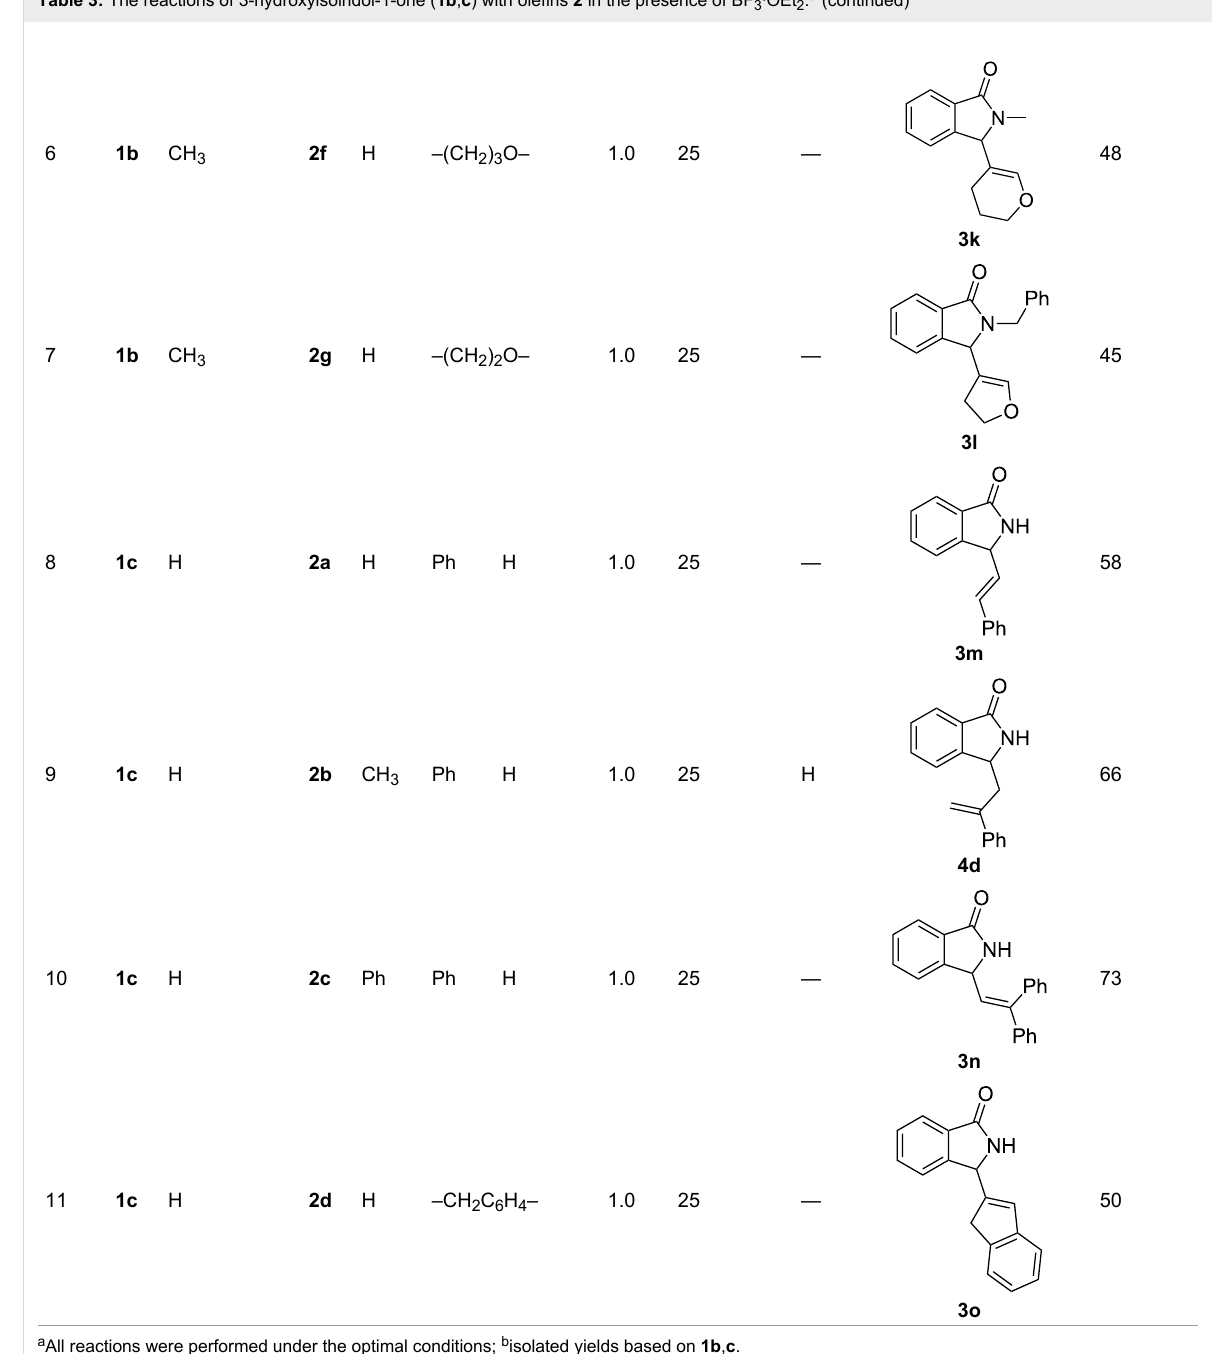
Table 3: The reactions of 3-hydroxyisoindol-1-one ( 1b , c ) with olefins 2 in the presence of BF 3 ·OEt 2 . a